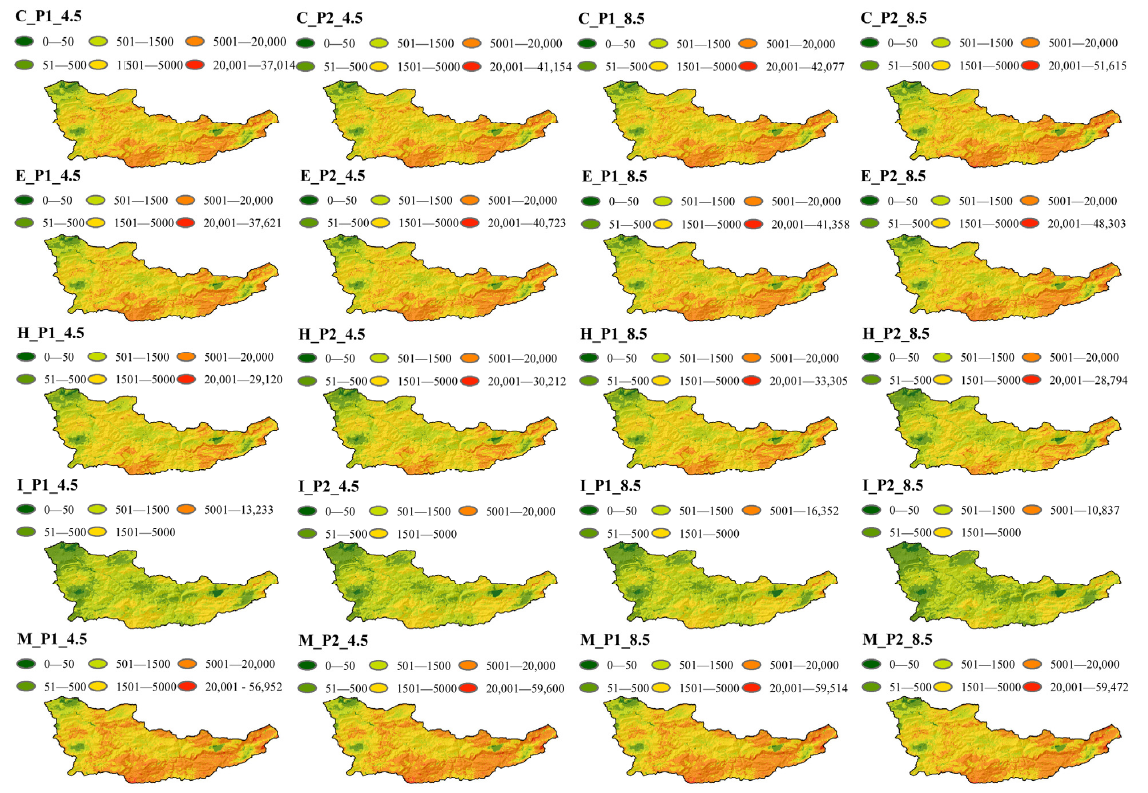
Figure 10. Soil erosion rates of the RCMs models under RCP4.5 and RCP8.5 for the periods 2030–2060